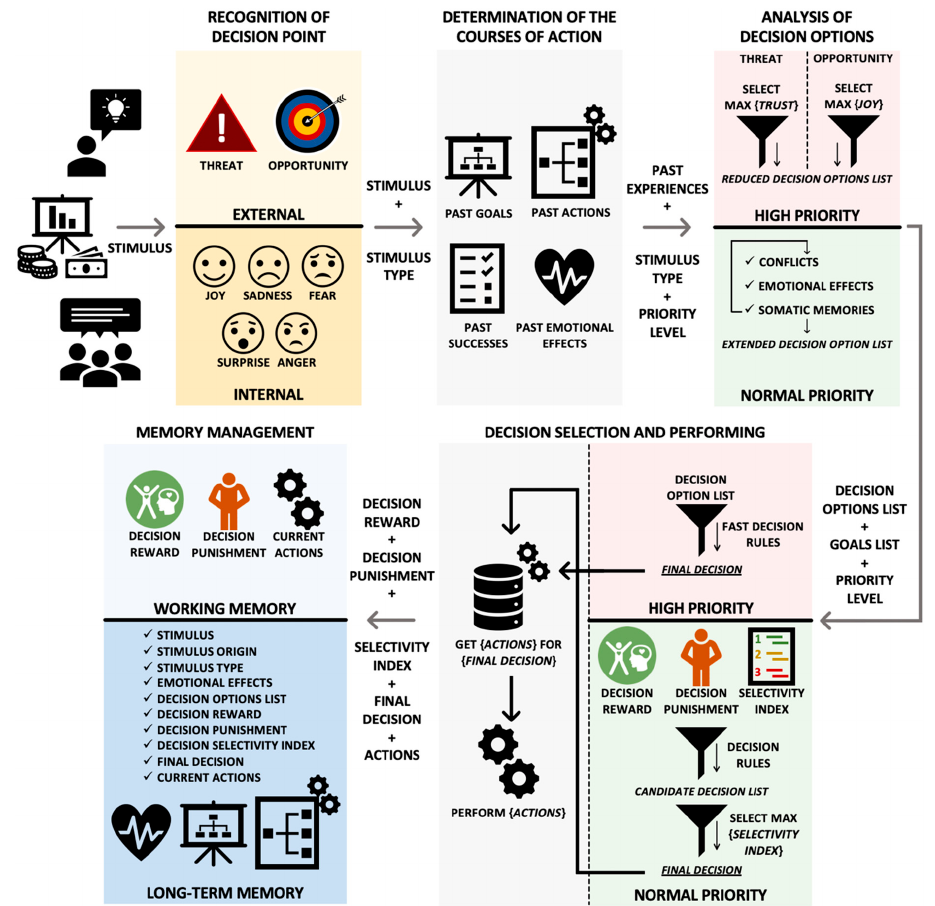
Figure 2. Unified decision-making process considering artificial somatic markers.